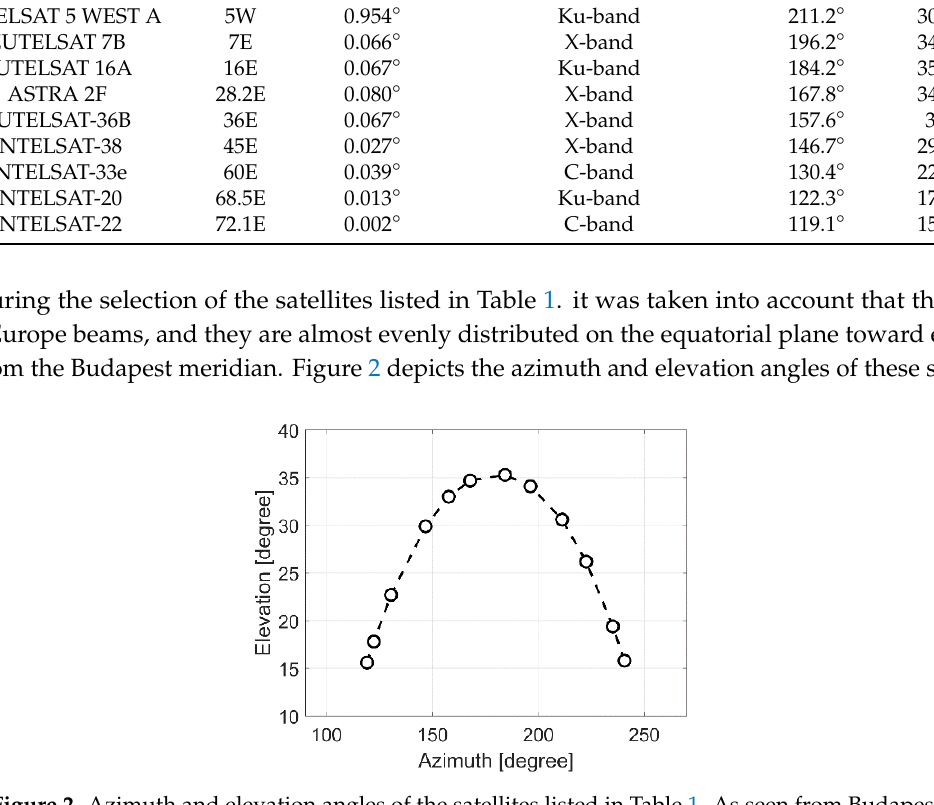
Figure 2. Azimuth and elevation angles of the satellites listed in Table 1. as seen from Budapest.